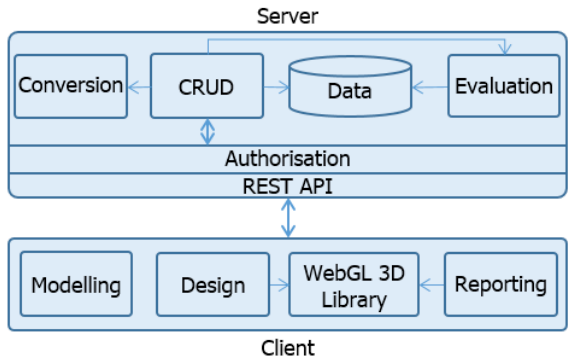
Figure 6: Initial draft of system architecture